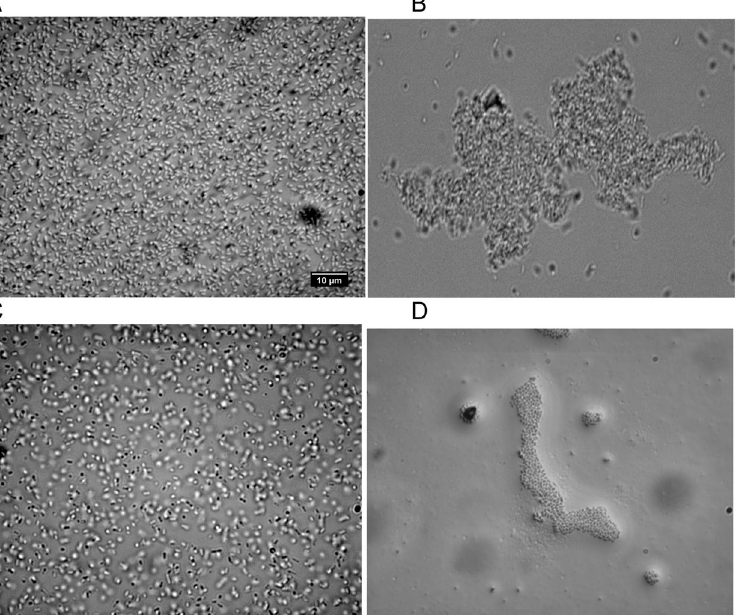
Figure 4. Image of strain G50 immediately obtained in a solution without ( A ), with cranberry (190 μ g/mL) ( B ), with propolis (102.4 μ /mL) ( C ) and with cranberry + propolis ( D ) with an inverse